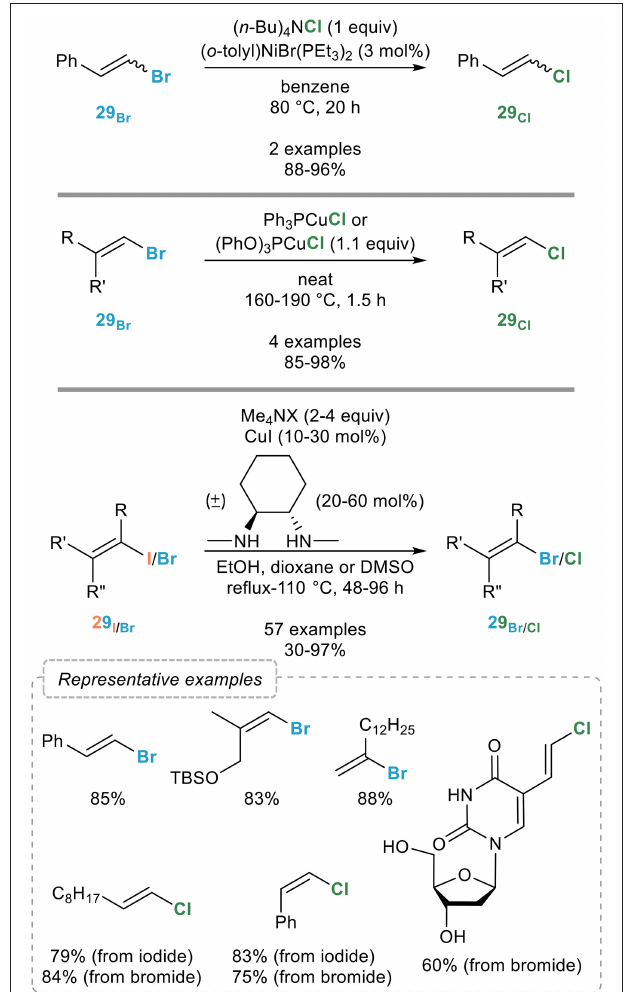
FIGURE 17 | Vinylic retro-Finkelstein